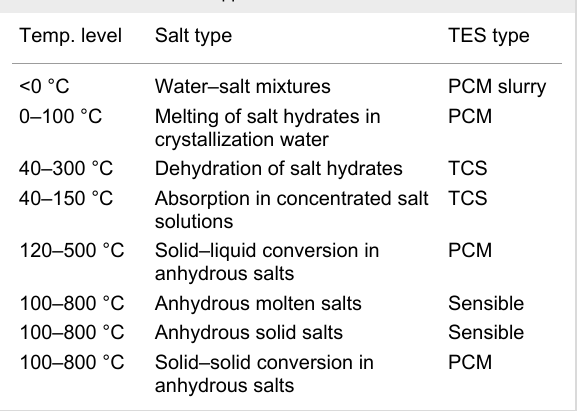
Table 1: Overview of salt application. Temp.